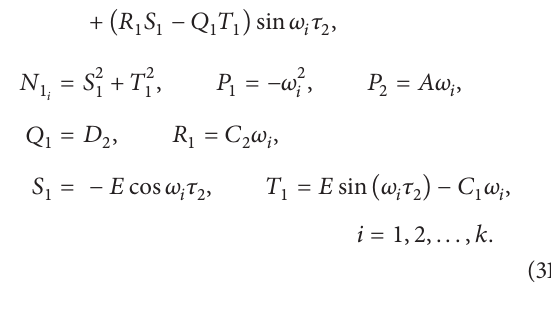
> 𝜏 ) . These figures show that the coexistence equilibrium is stable for 𝜏 2 2 0 = 0.4205 2